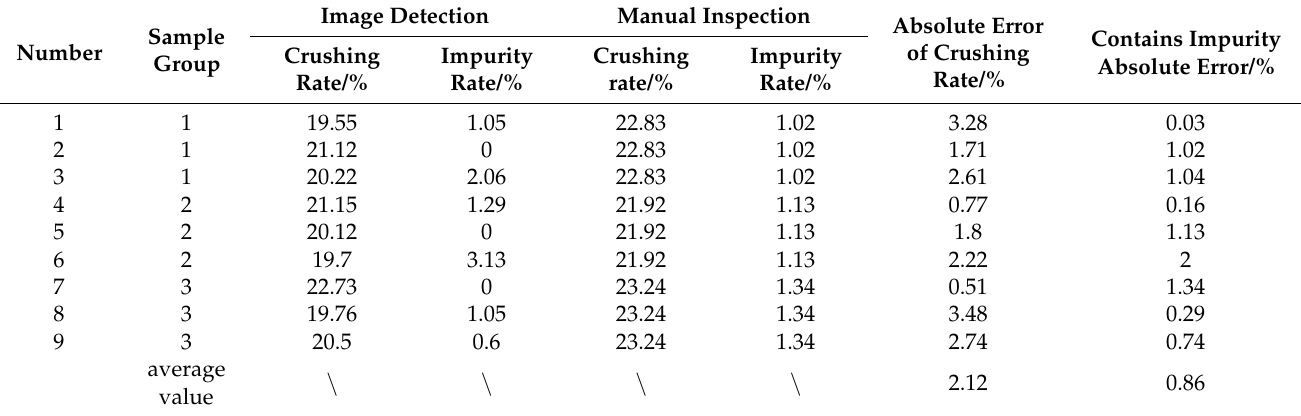
Table 9. The results of the second experiment were dynamically monitored by the yield of harvested maize grains’ impurity and crushing